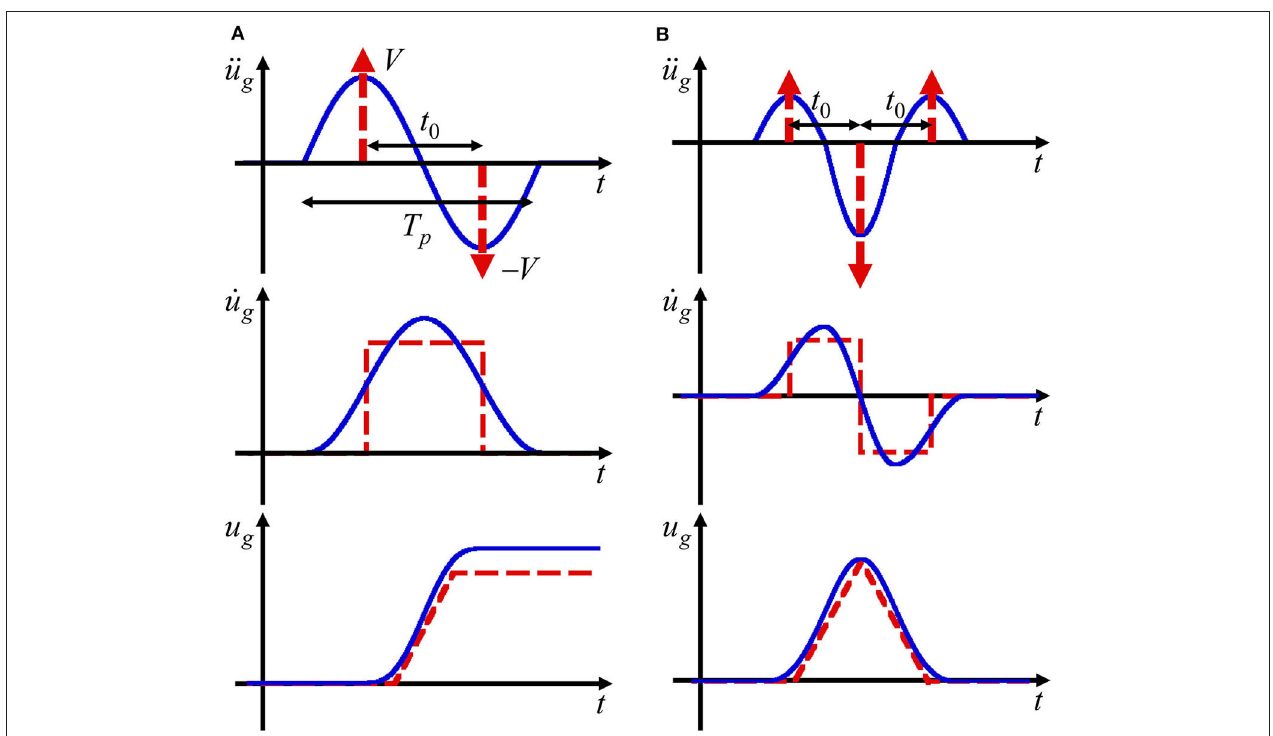
FIGURE 1 | Transformation of acceleration wavelets into a series of impulses. (A) Fling-step input (blue) and double impulse (red). (B) Forward-directivity input (blue) and triple impulse (red) ( Kojima and Takewaki,